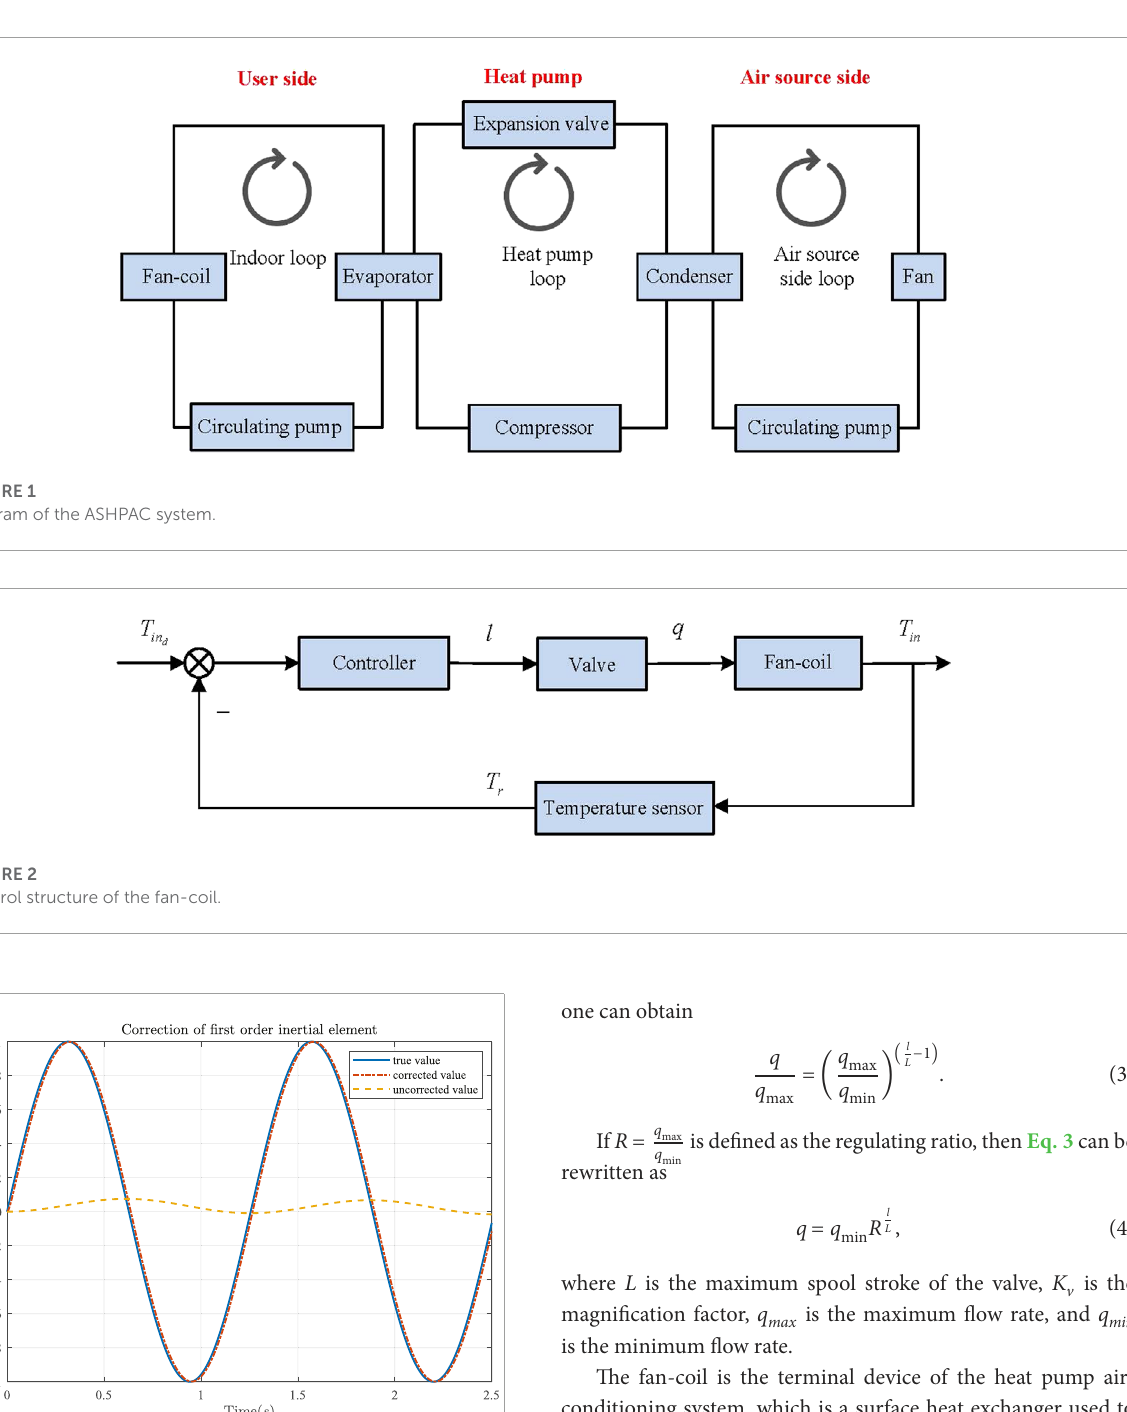
FIGURE 3 Correction of the first-order inertial